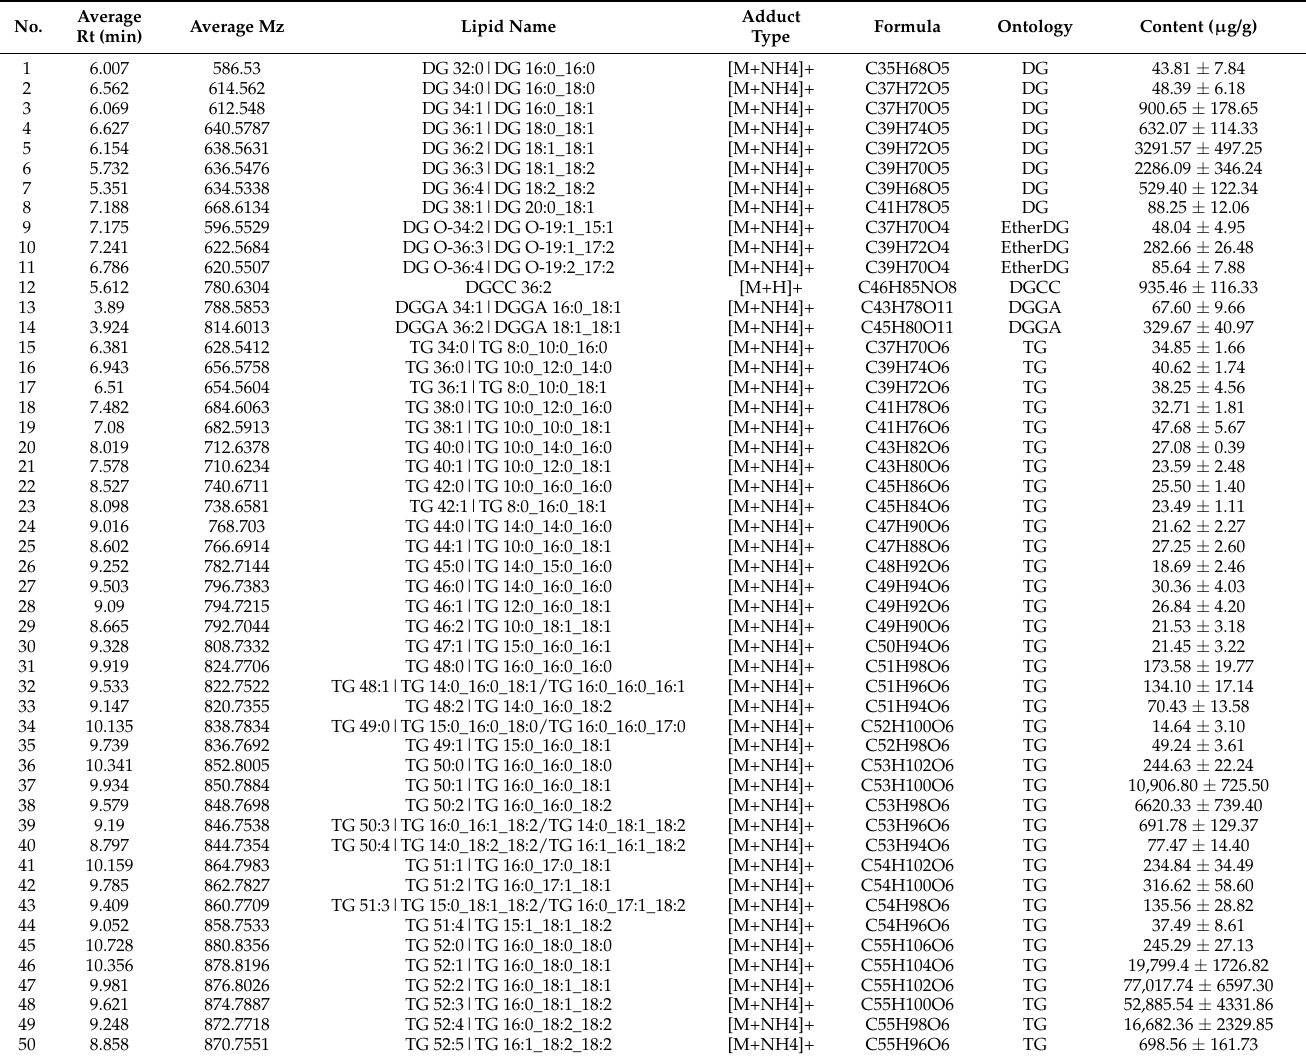
Table 1. Composition of the 102 glycerides in cashew nut kernel